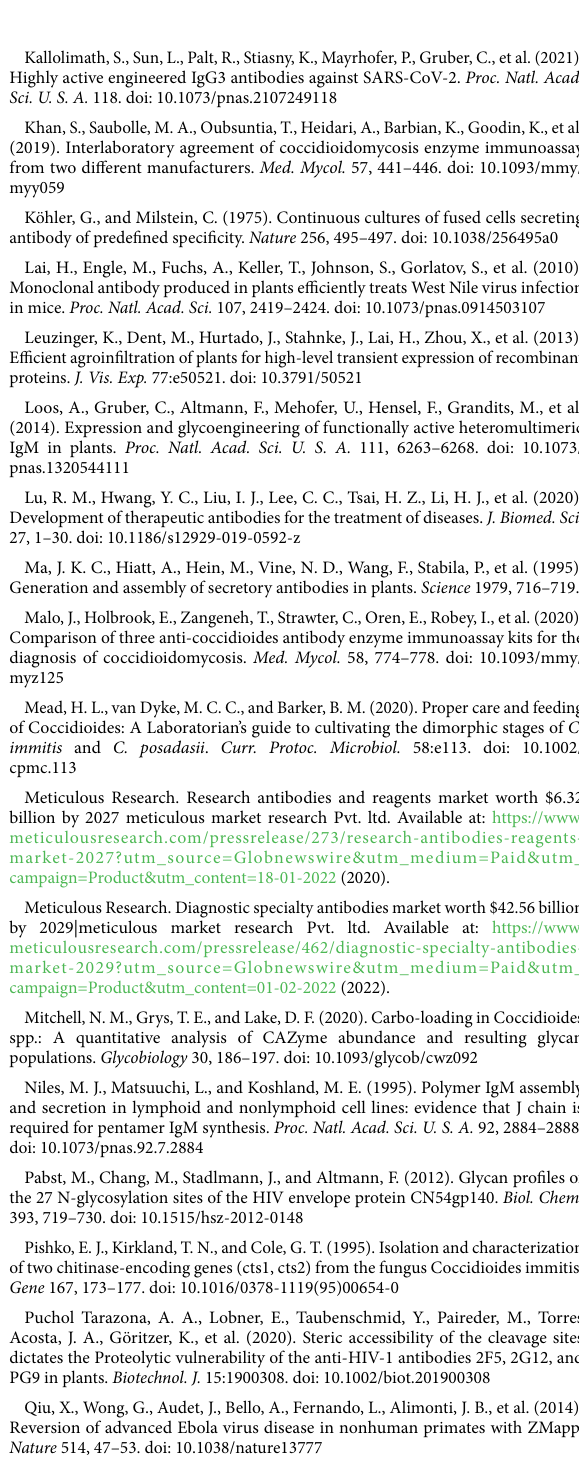
Proteome Discover 2.5. Human IgM heavy chain (mu) constant domain (accession no. P01871) was identified with 89.58%. Spectra were also analyzed by PEAKS against the full amino acid sequence of P-4H2-IgM mu HC, which is presented in the figure. Sequence highlighted in gray indicates regions with peptides identified in the unexpected bands (between 37 and 50 kDa). Blue bars illustrate the frequency of detection for individual peptides. Amino acids with orange and red highlights indicate carbamidomethylation and oxidation sites,